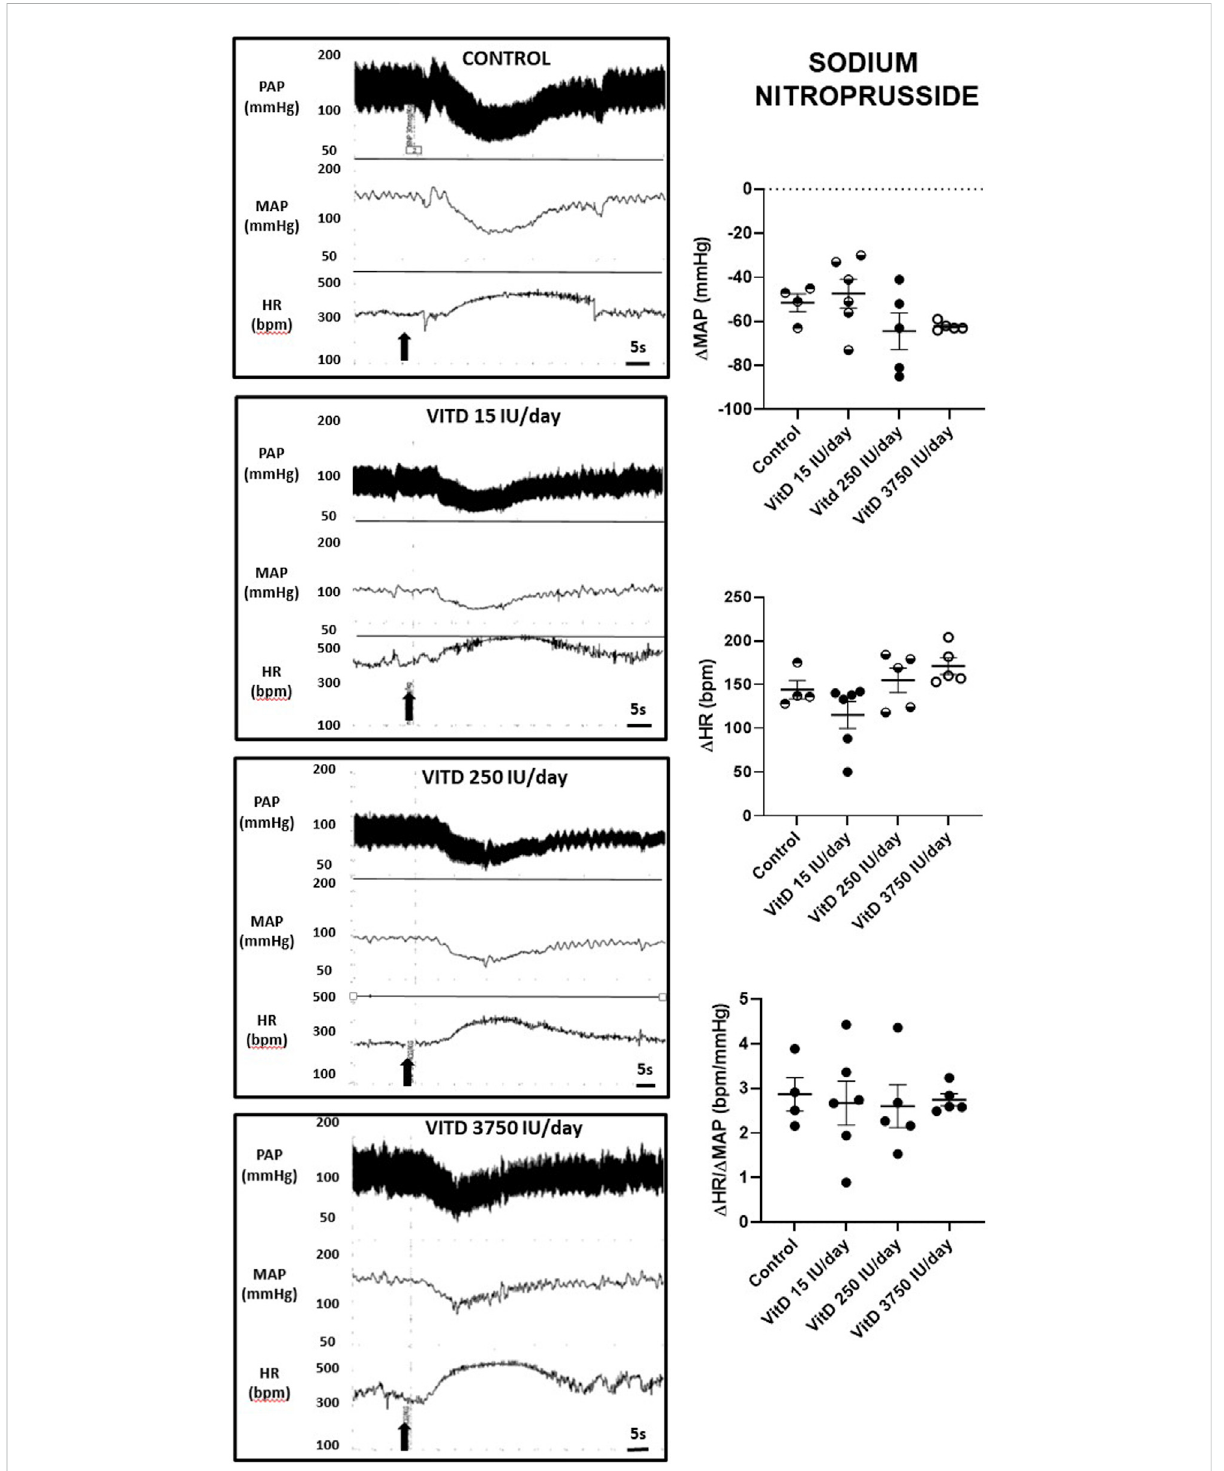
FIGURE 2 Left panels — Pulsatile arterial pressure (PAP), mean arterial pressure (MAP, mmHg), and heart rate (HR, bpm) tracings in Control, and Vitamin D 15, 250 and 3,750 IU/day treated-rats for 3 days in which sodium nitroprusside (30 μ g/kg of b.w.) was intravenously injected in bolus. Right panels – Change in mean arterial pressure ( Δ MAP, mmHg), heart rate ( Δ HR, bpm), and index of baroreceptor re fl ex ( Δ HR/ Δ MAP in module, bpm/ mmHg) yielded by a depressor dose of sodium nitroprusside (30 μ g/kg of b.w.) in Control rats and submitted to supplementation with different doses of Vitamin D (VitD 15, 250, 3,750 IU/day) for 3 days. ( n = 4 – 6/group). One-way ANOVA followed by Tukey posttest. * p < 0.05 vs.